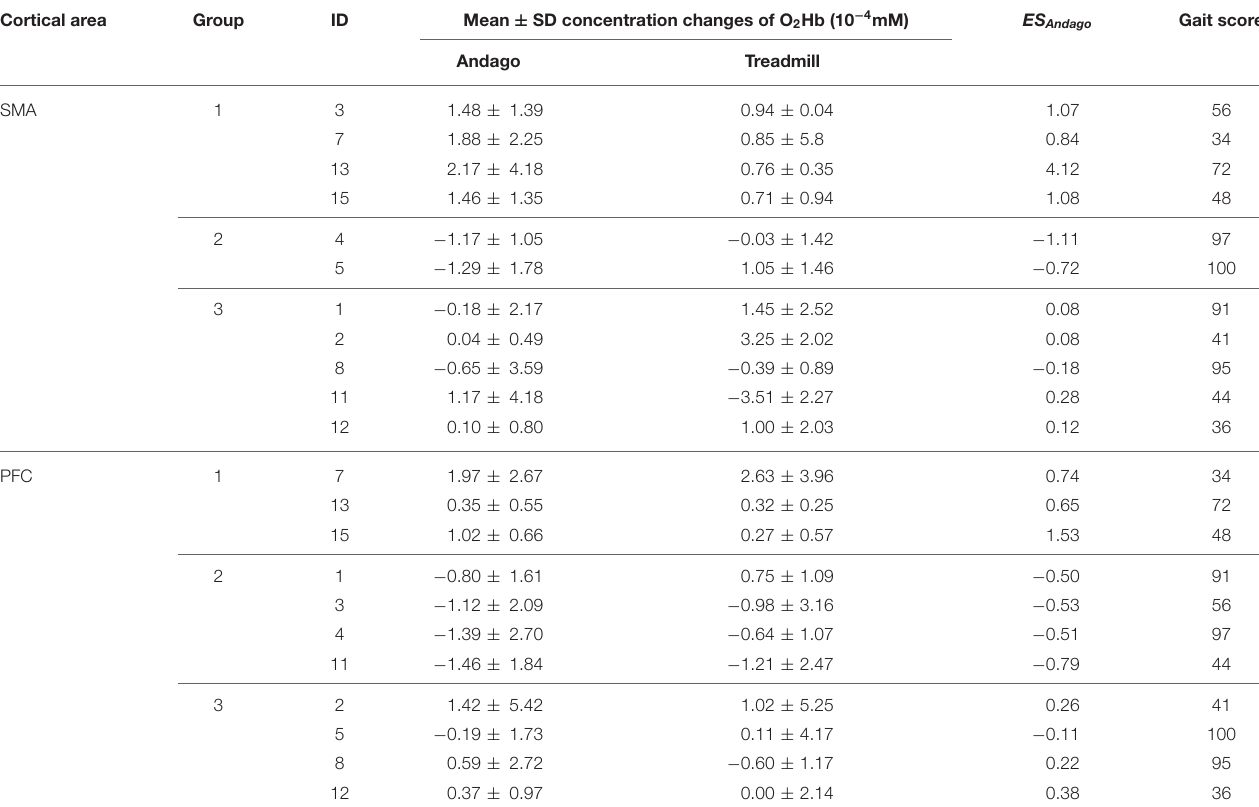
TABLE 2 | Changes in oxygenated hemoglobin levels for each participant. Cortical